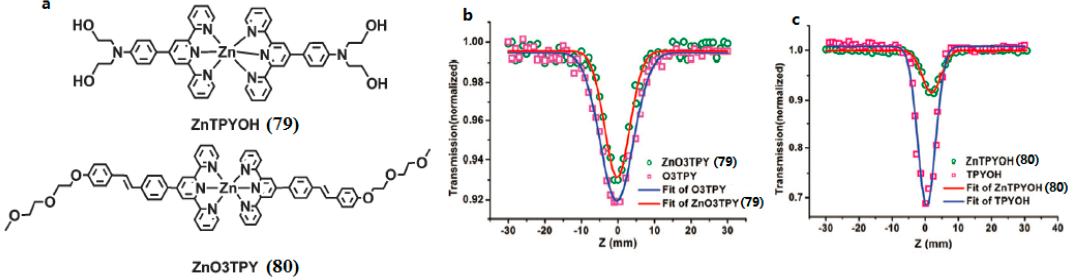
Figure 19. ( a ) The structures of 79 , 80 ; Open-aperture Z-scan experimental data and fitting curves for 79 ( b ), 80 ( c ) and their free ligands in H 2 O–acetonitrile (4:1) under a 750 nm laser beam. The concentration was 1.0 × 10 − 3 M.